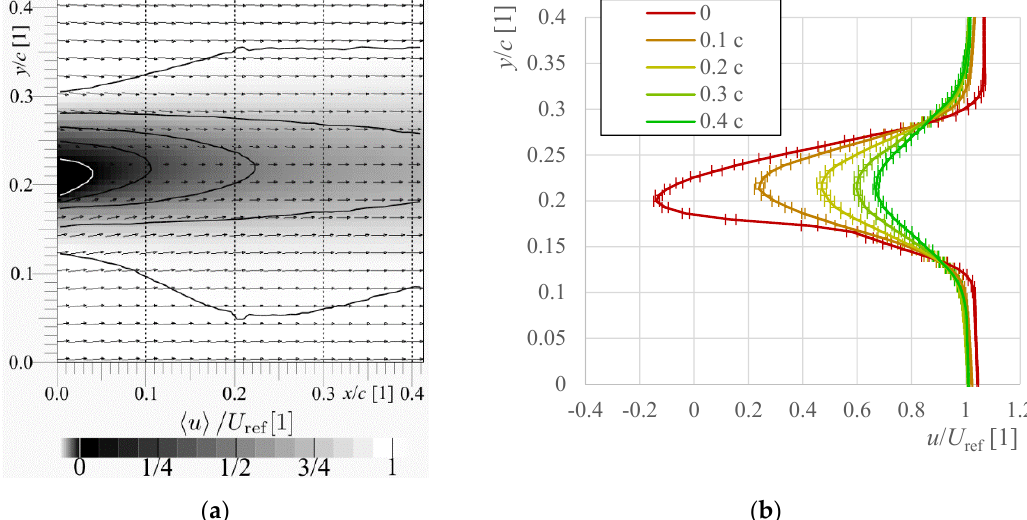
Figure 2. Ensemble average stream-wise velocity. Panel ( a ) shows the map of average u (grayscale), the white isotach separates the area of back flow, the last black isotach separates the area of average velocity larger than reference velocity measured in empty wind tunnel. Panel ( b ) contains the velocity profiles at several distances from the trailing edge denoted as dashed lines in panel ( a ) distinguished via color: we apologize to readers with grayscale printer.